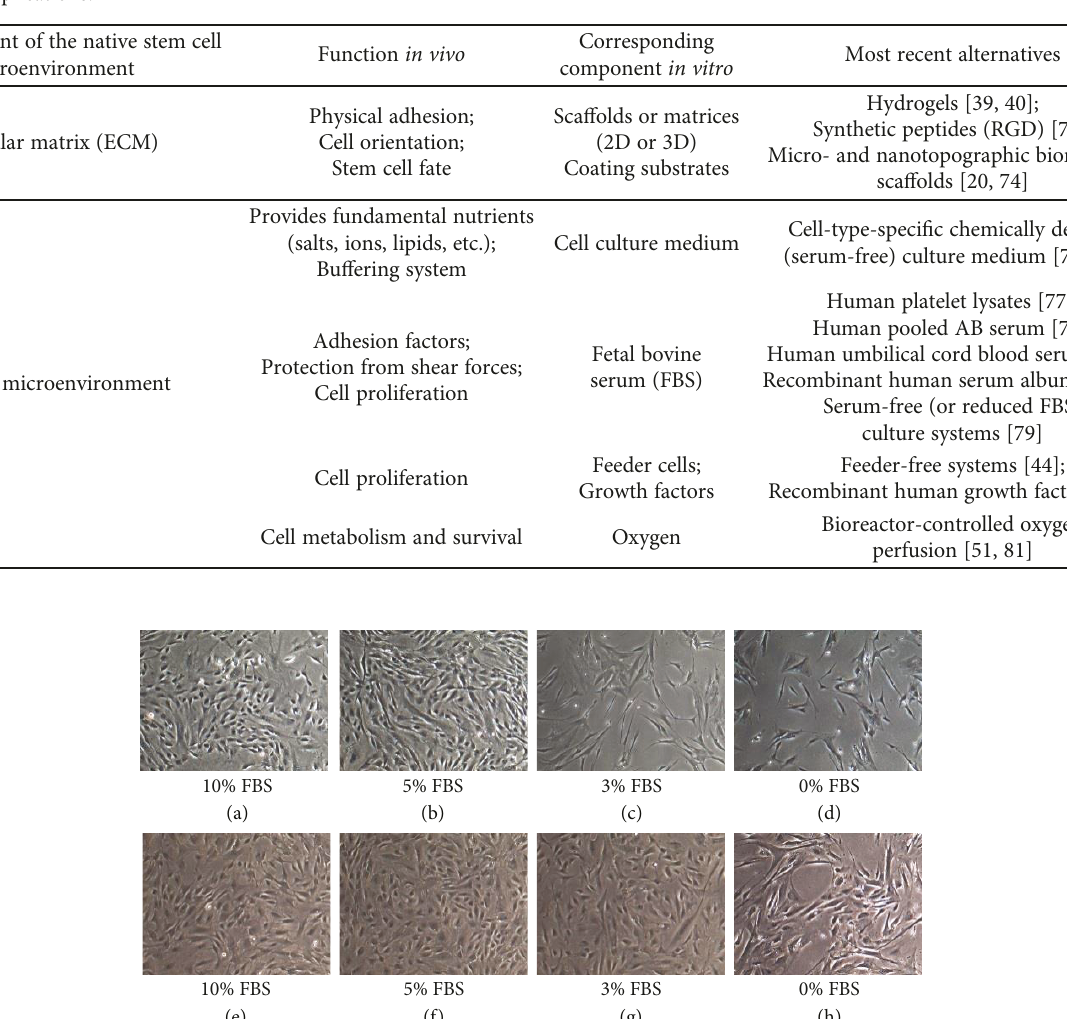
Table 1: A comprehensive overview of the current available alternatives to recreate the stem cell microenvironment in vitro for clinical applications.